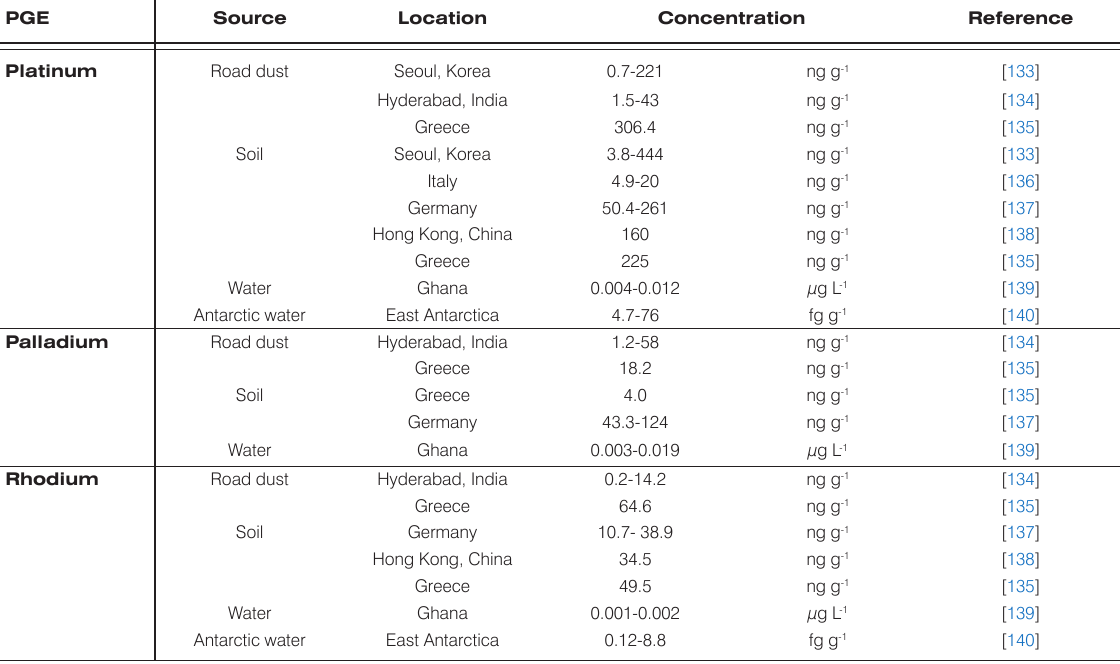
Table 2. Table providing PGE concentrations measured in road dust, soil and water from various locations from 2007 to 2012. The locations are divided according to PGE, source and found concentration.